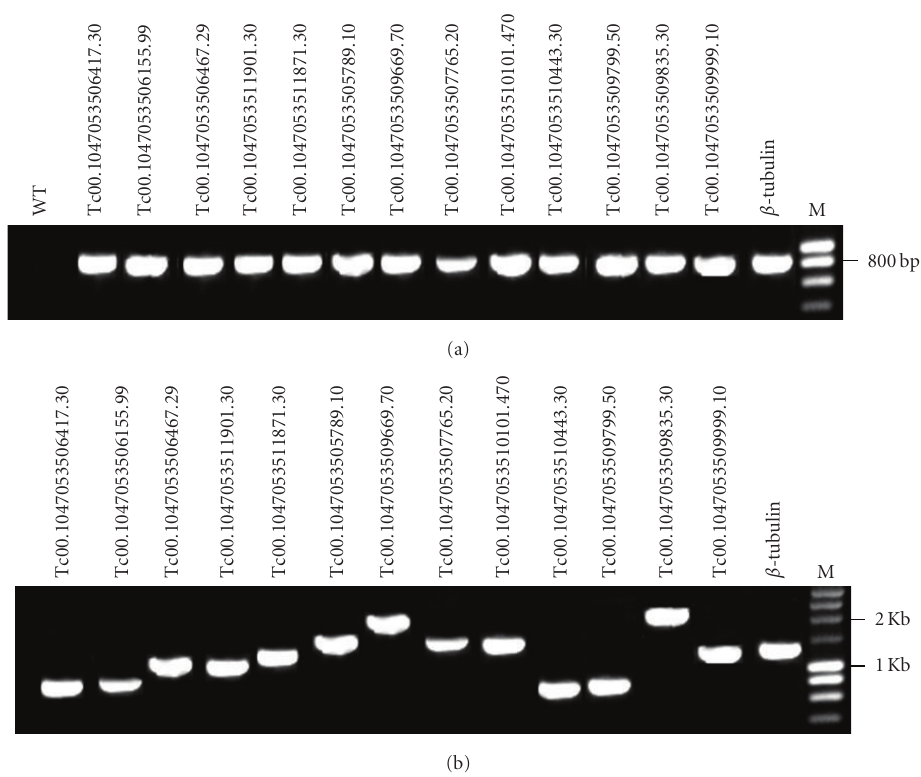
Figure 2: PCR analyses in episomally transfected L. infantum promastigotes. (a)Amplification of NEO gene fragment in L. infantum episomally transfected promastigotes. (b) Amplification of full length transfected genes in L. infantum promastigotes. Specific forward and Reverse PCR primers and gene lengths are listed in order in Table 1. WT: Wild Type Parasites. M: Molecular marker: Smart Ladder